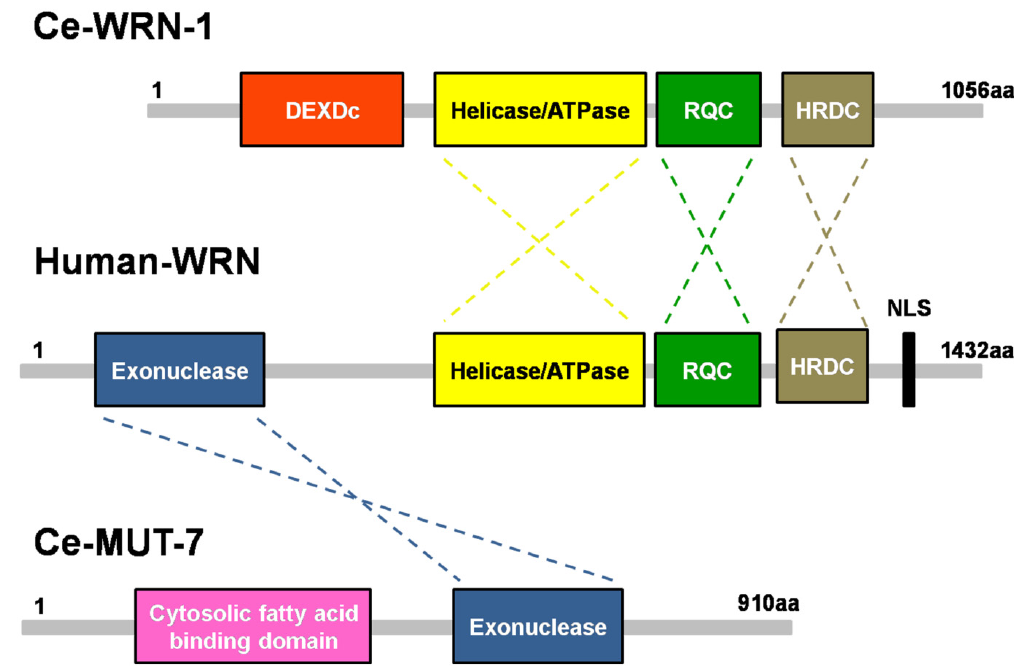
Figure 1. Domain structures of C. elegans MUT-7 and CeWRN-1 and human WRN. The 3 ′ -5 ′ exonuclease domain of nematode MUT-7 has a 29% amino acid sequence identity to human WRN. The three helicase domains in the human WRN, helicase/ATPase, RecQ C-terminal domain (RQC), and helicase-and-RNaseD C-terminal (HRDC) domain, share 43%, 25%, and 16% identity, respectively, with the same domains of nematode WRN-1.